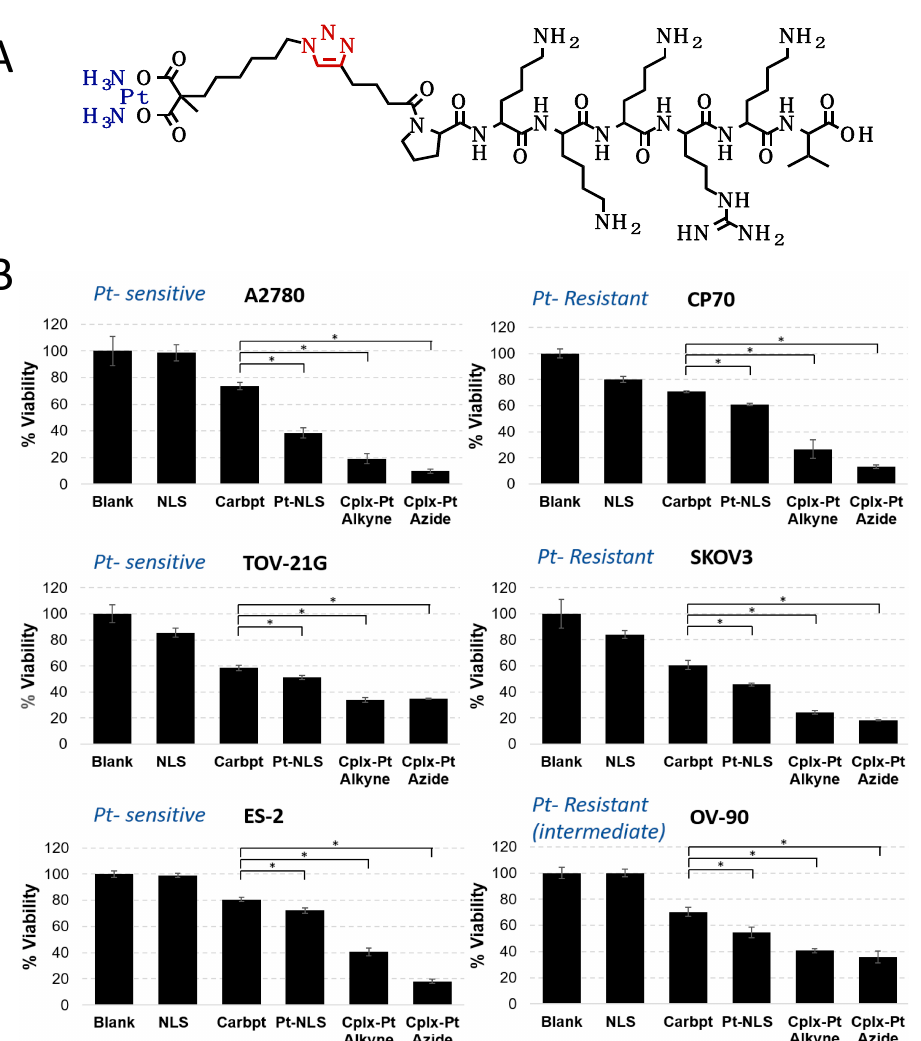
Figure 7. ( A ) Chemical structure of the Pt(II)- nuclear localization sequence (NLS) hybrid. ( B ) Viability of platinum sensitive (left) and resistant (right) cells after 72 h incubation with Pt-NLS hybrid and controls. * Each column represents the mean and standard deviation of N = 3 and p < 0.005. Reprinted with permission from reference [116].